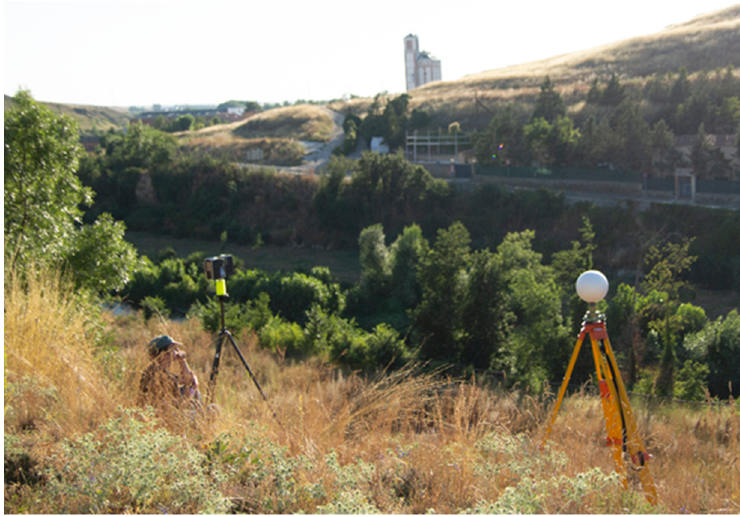
Figure 3. Terrestrial Laser Scanner device used for the detailed digitalization of the rock shelter.